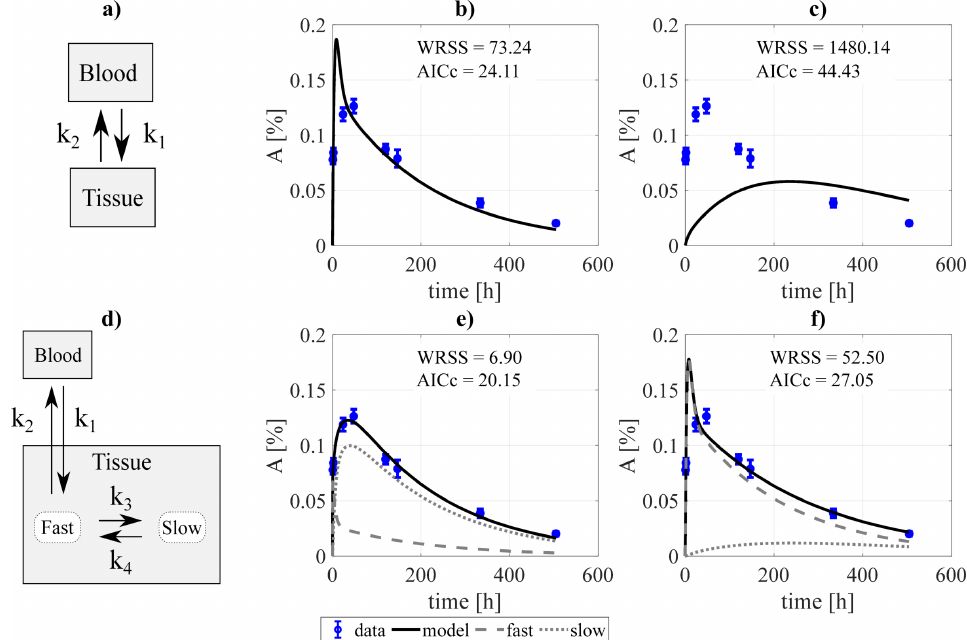
Figure 1. Example of the decoupling method for the tumor subsystem, constrained by a biexponential forcing function for the blood compartment. Panel ( a ) shows a simple two-compartment model which was fitted to the data assuming: ( b ) bidirectional blood-tissue exchange, and ( c ) only one direction blood-tissue ( k 2 = 0). Panel ( d ) shows a three-compartment model which was fitted assuming: ( e ) four exchange directions blood-fast and fast-slow, and ( f ) three exchange routes (slow-fast is canceled, k 4 = 0). WRSS and AIC c refer to the weighted residual sum of squares and Akaike Information Criterion with sample size correction of the fits.